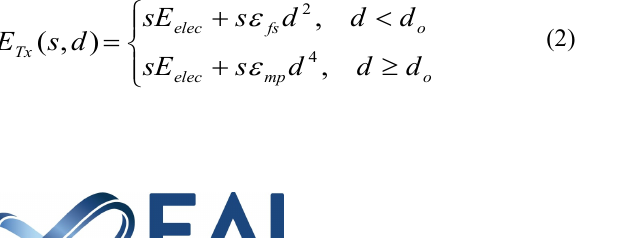
Algorithm1: CH selection phase in